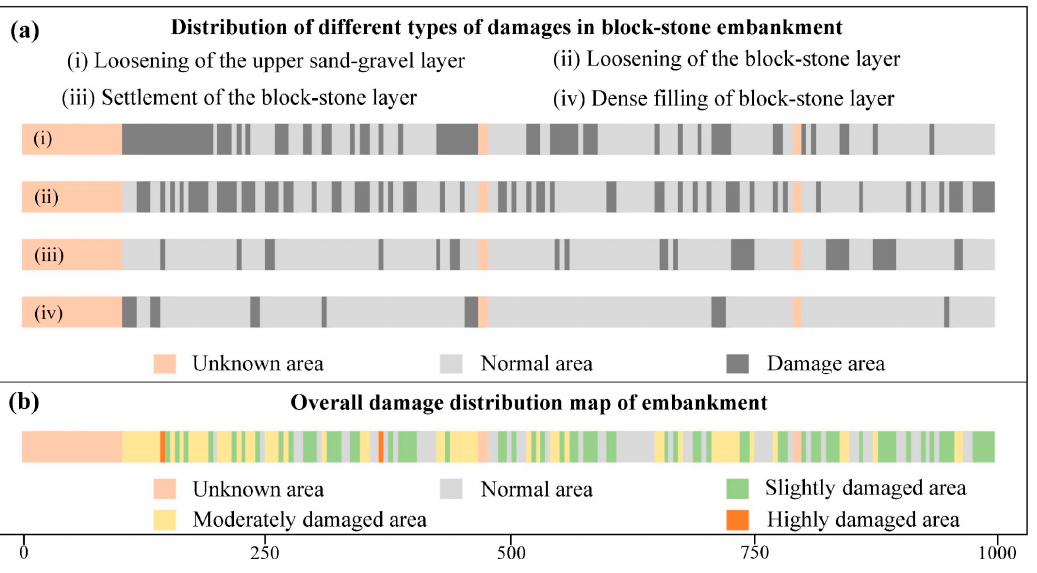
Figure 13. For the K3024 to K3025 section: ( a ) distribution of different types of damage in the block-stone embankment. Note: the unit (five meters as a unit) was considered damaged if the unit was damaged more than half, otherwise, it was a normal unit. ( b ) overall damage situation of the em- bankment. Note: The degree of embankment damage was based on the number of damaged species on each unit.